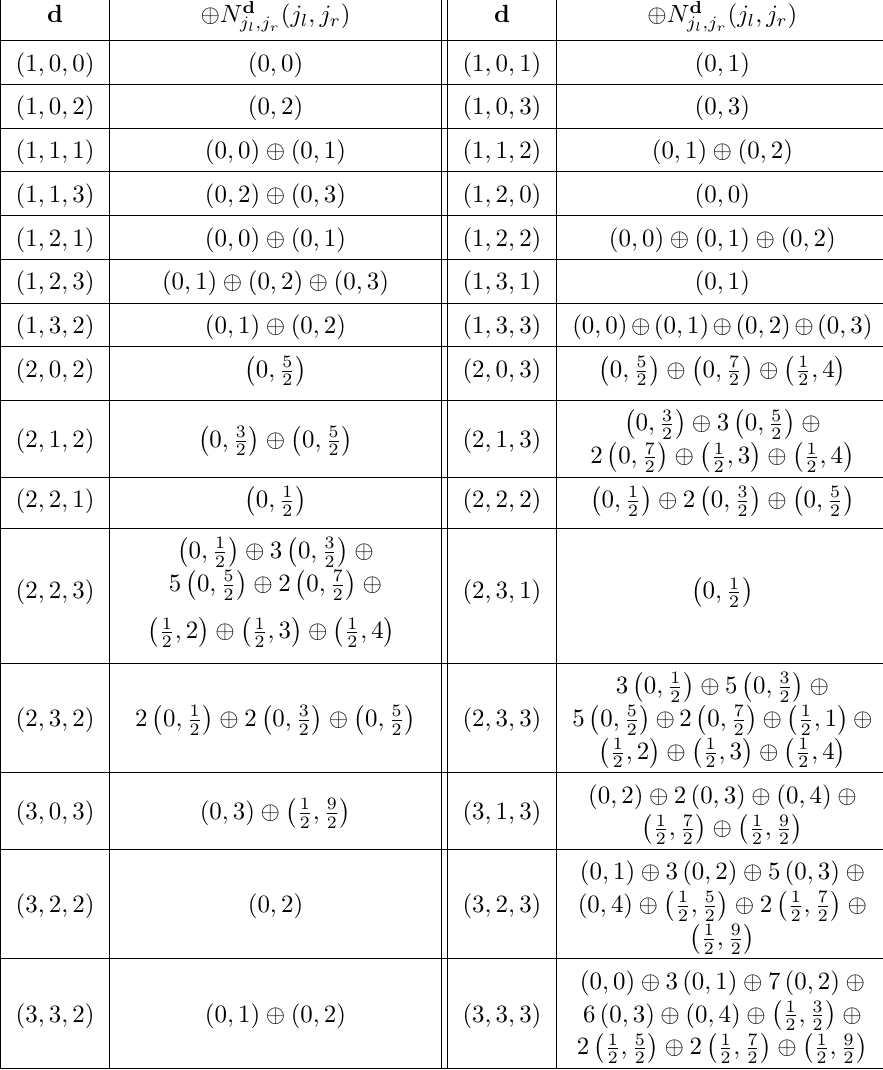
Table 7. BPS spectrum of the SU(3) 6 theory for d i ≤ 3 . Here, d = ( d 1 , d 2 , d 3 ) labels the BPS states with charge d 1 e 2 + d 2 f 1 + d 3 f 2